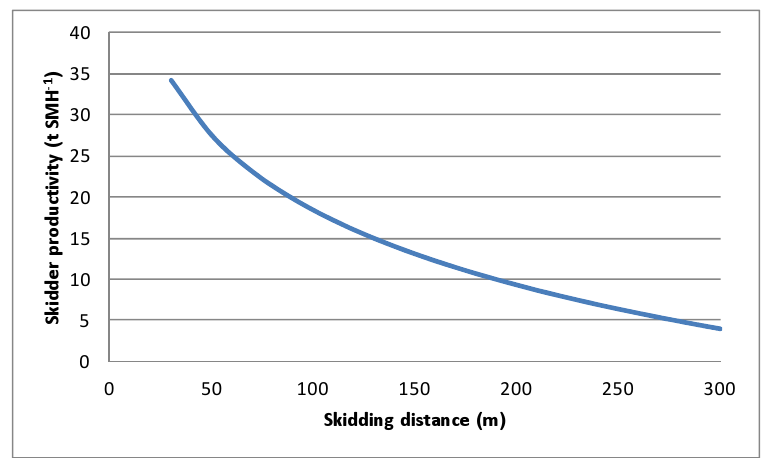
Figure 3. Skidder productivity as a function of skidding distance.